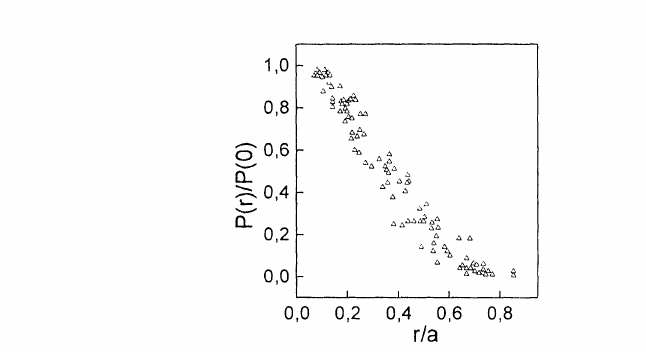
FIGURE 5 The dependence of relative plasma pressure, p(r)/p(O) on radius p= r/a, where a--i-/Bt for different tokamak devices (T-10, T-11, TFR, TM-3, PLT, ASDEX,